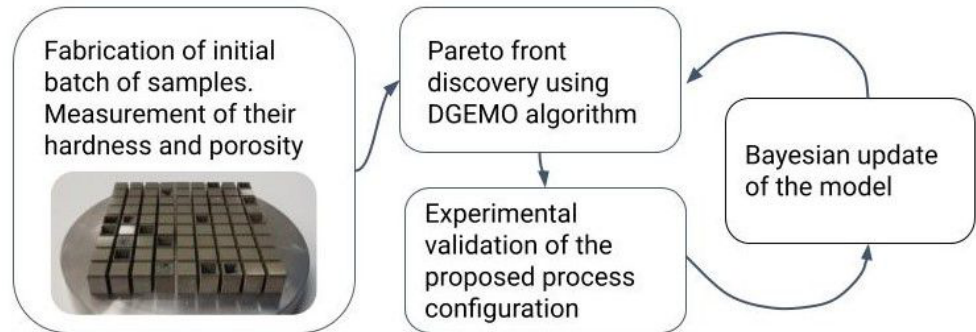
Figure 2. The workflow pipeline designed to find the set of optimal process parameters using